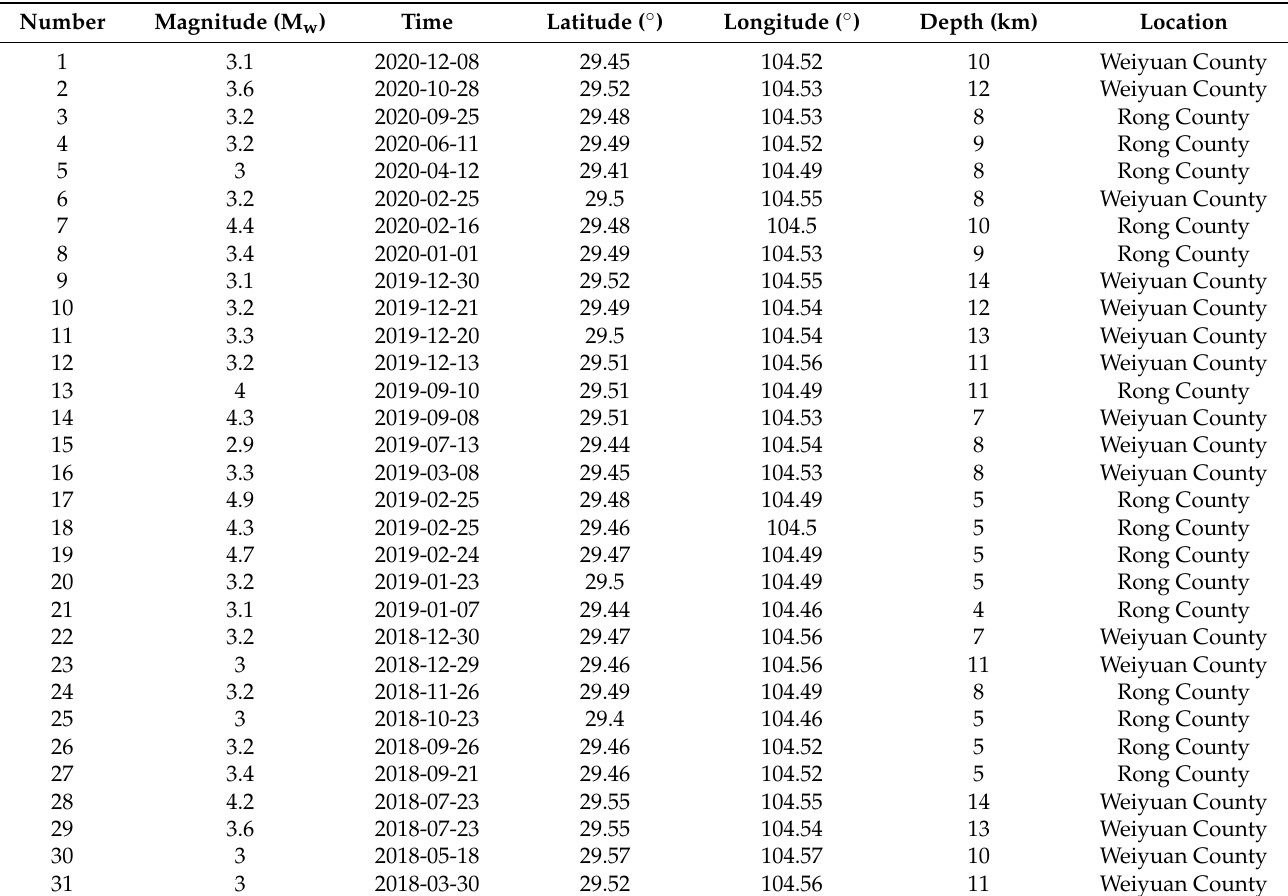
Table 1. Information on the small-magnitude earthquakes in the study